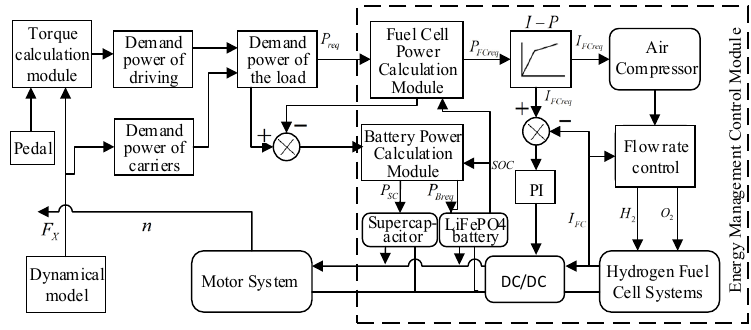
Figure 5. The energy system of the hybrid